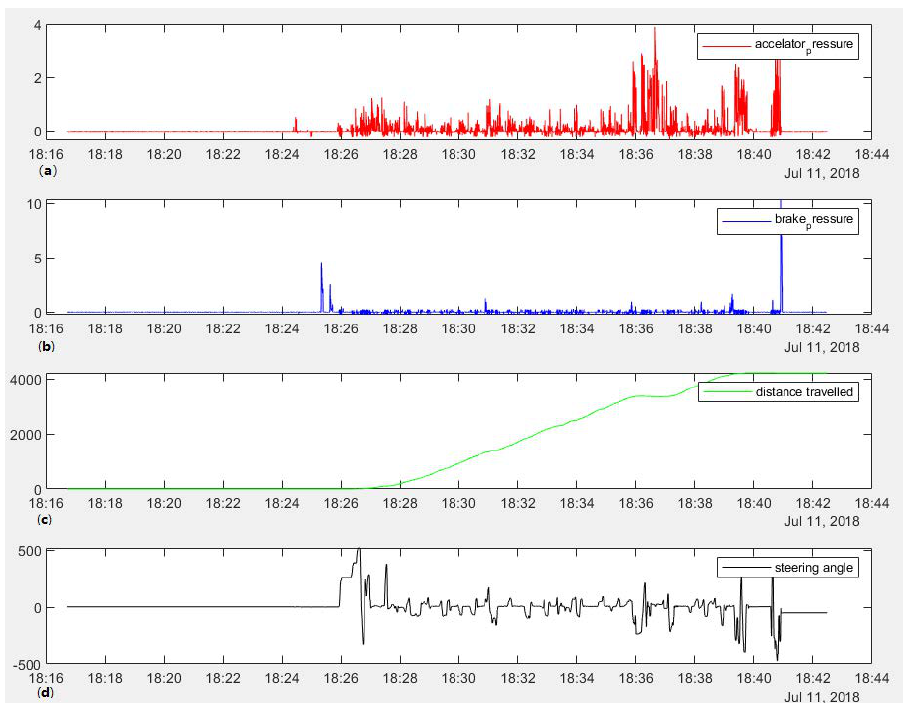
Figure 5. Data synchronisation with timestamp. ( a ) accelerator; ( b ) break; ( c ) distance; ( d ) steering wheel angle.